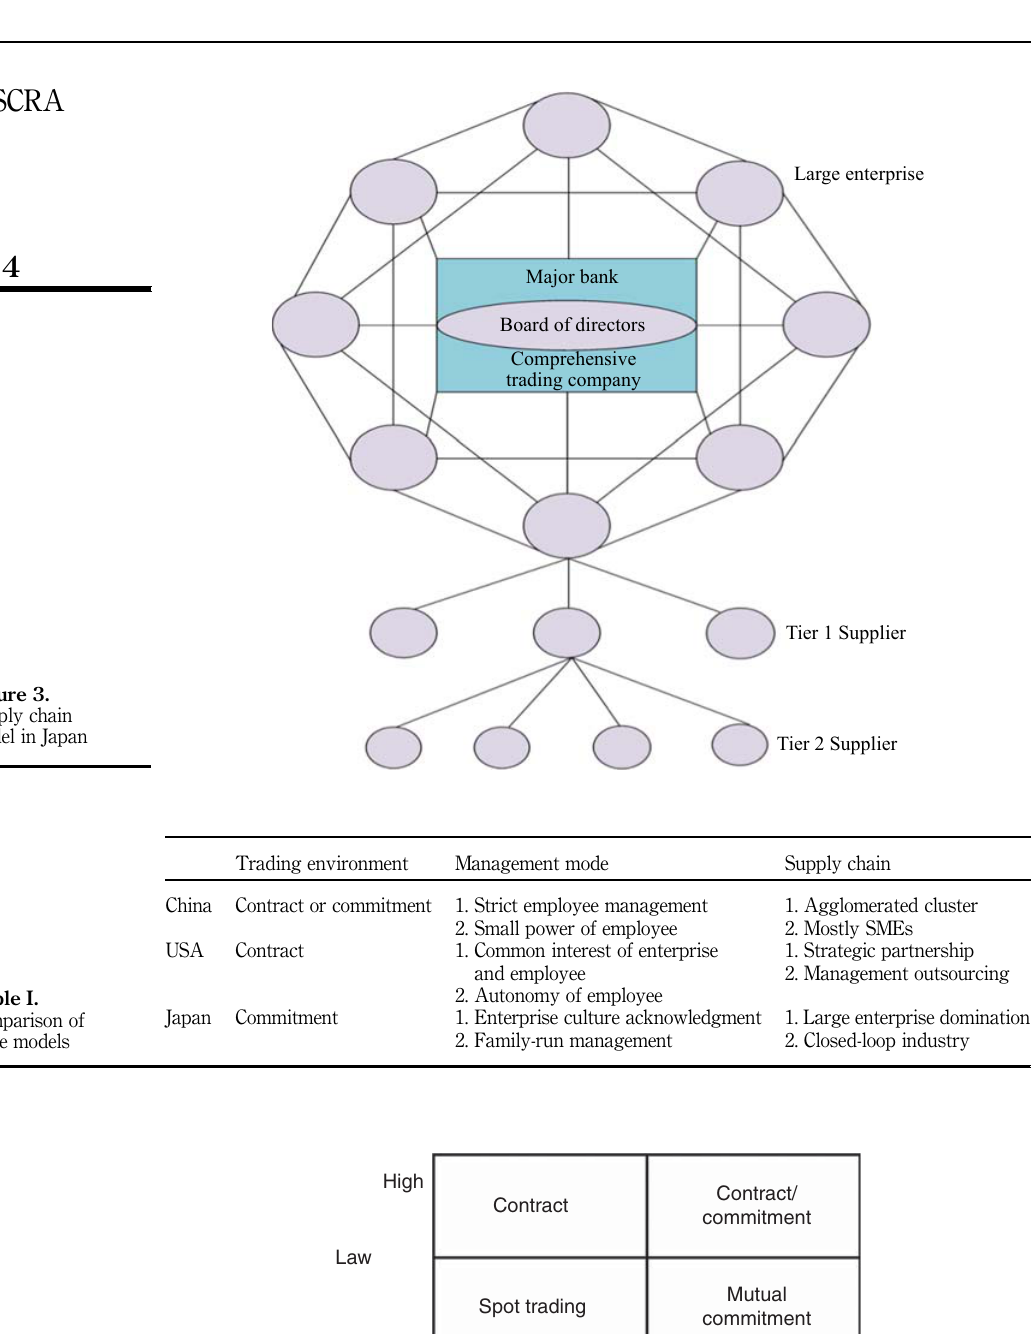
Figure 4. Factor table of trading